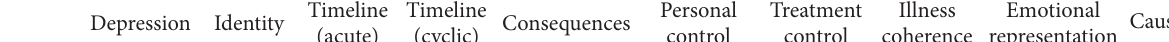
Table 4: Relationship between depressive symptoms and illness perception (Spearman correlation).